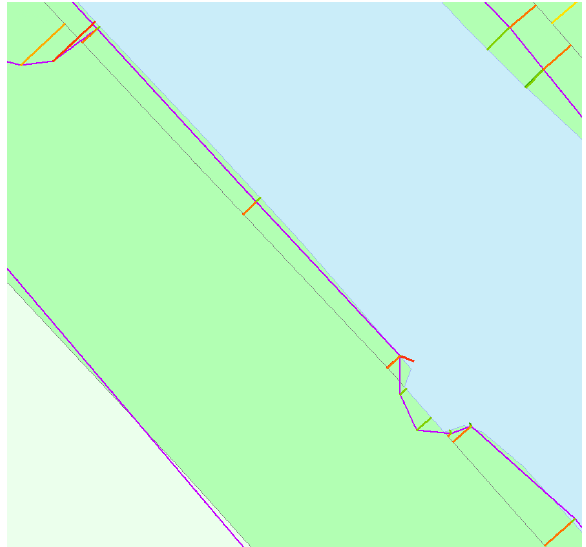
Figure 8. ALKIS (black) and ATKIS (purple) data overlay on the riverbank of Weser in Hameln. Links with similarity indication (coloured